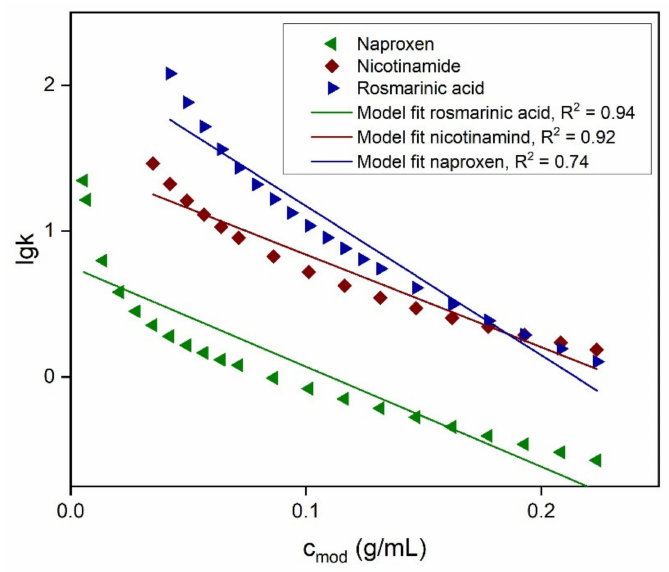
Figure 3. Retention factors of various solutes on SIL-60 and model fittings according to DIM-Lin-kc. SFC conditions: 200 bar, 40 ◦ C, injection volume 2 µ L, flow rate 2 mL min − 1